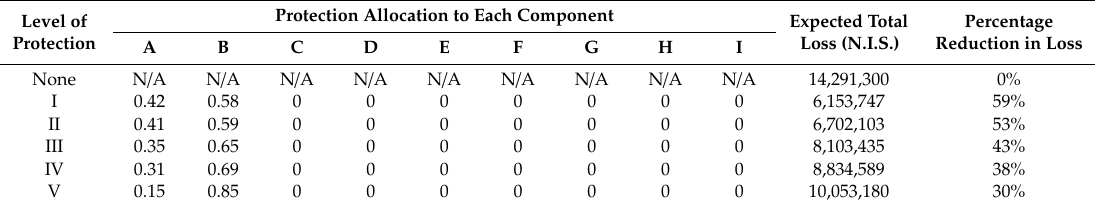
Table 6. Protection Strategy Arrangements Aimed at Improving Robustness